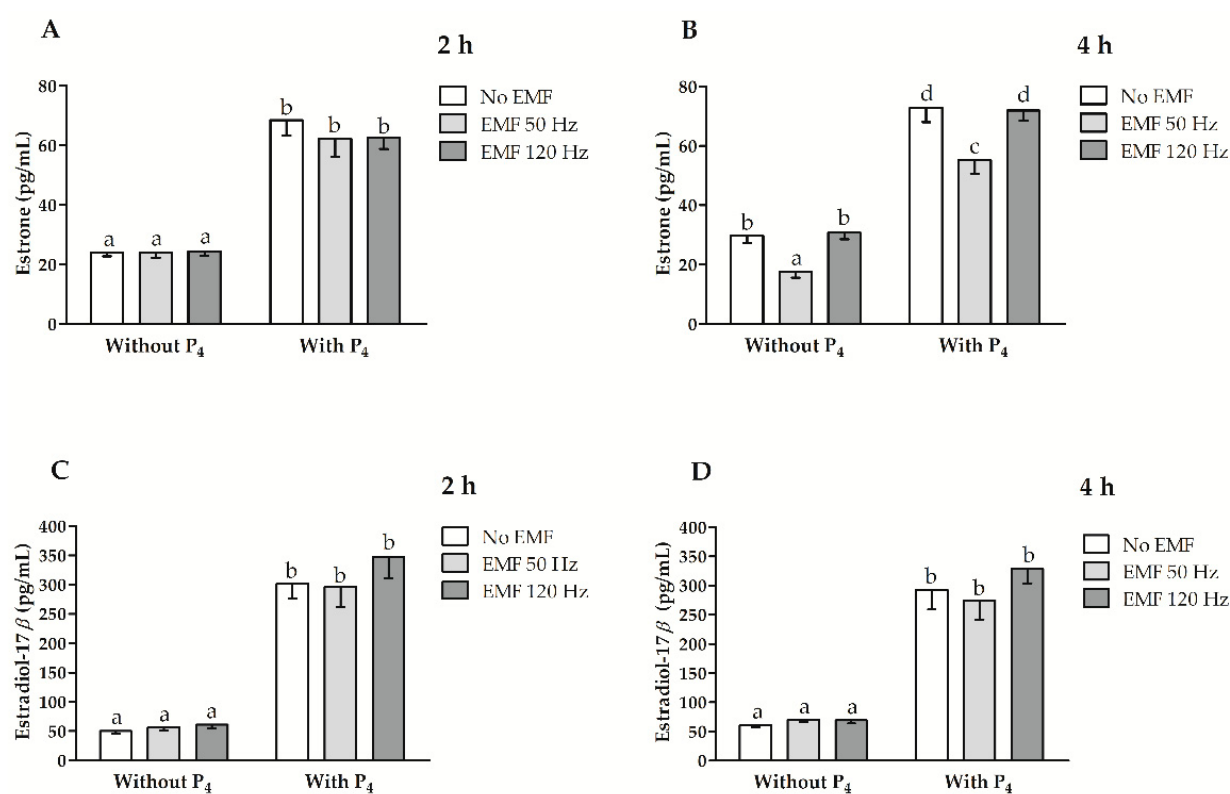
Figure 5. The myometrial release of estrone ( A , B ) and estradiol-17 β ( C , D ) from myometrial slices collected from pigs during days 15–16 of early pregnancy and treated in vitro with an EMF at 50 and 120 Hz for 2 h ( A , C ) and 4 h ( B , D ) of incubation with or without the inclusion of P 4 in the culture medium. Data is presented as mean ± SEM. Lower-case letters (a–d) above bars indicate statistically significant differences p ≤ 0.05 (multi-way ANOVA).